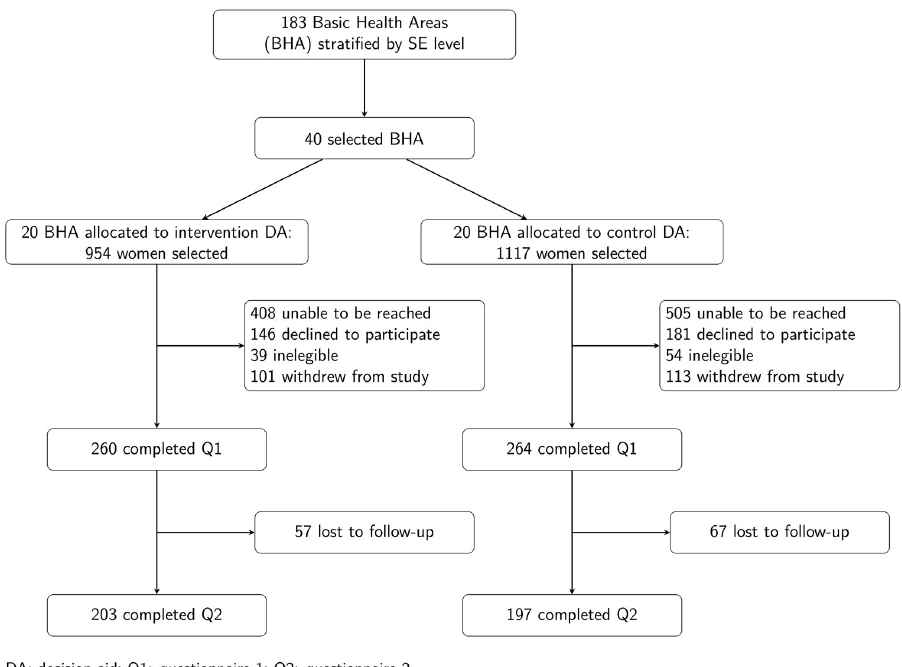
Fig 1. CONSORT flow